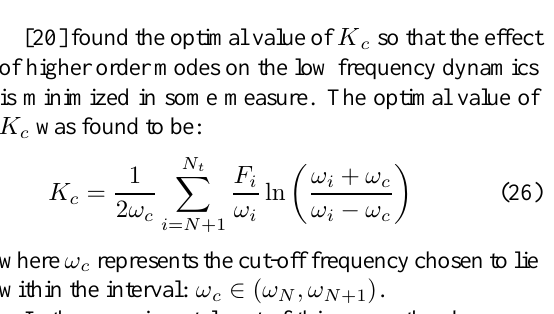
Fig. 3. Piezoelectric transducer charge